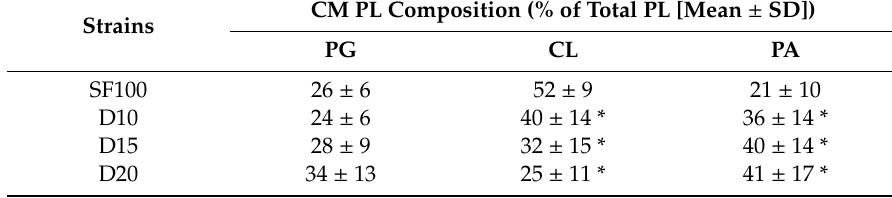
Table 2. Phospholipids (PL) content of study strains. CL: cardiolipin, PA: phosphatidic acid, PG: phosphatidylglycerol.